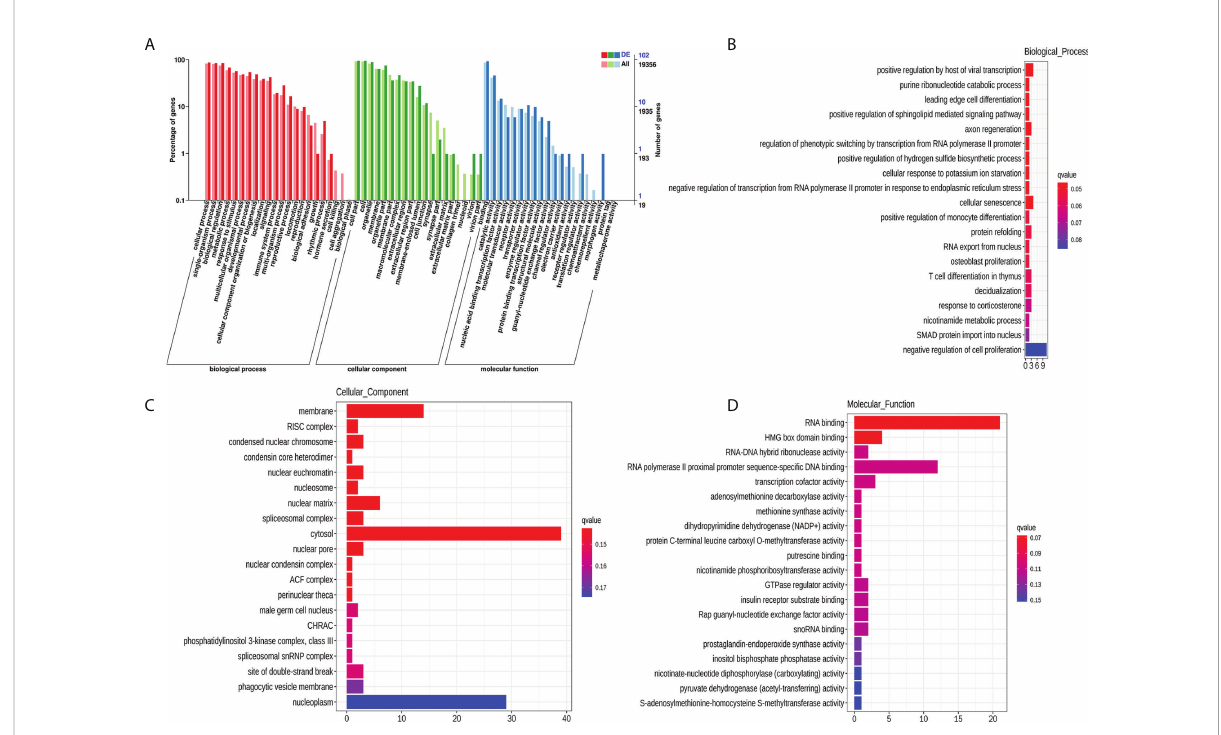
FIGURE 5 GO enrichment analysis of 112 DEMs. GO categories of DEMs (A) . Top 20 signi fi cantly enriched biological processes (B) , cellular components (C) , and molecular functions (D) of DEMs. The x-axis represents the number of mRNAs.